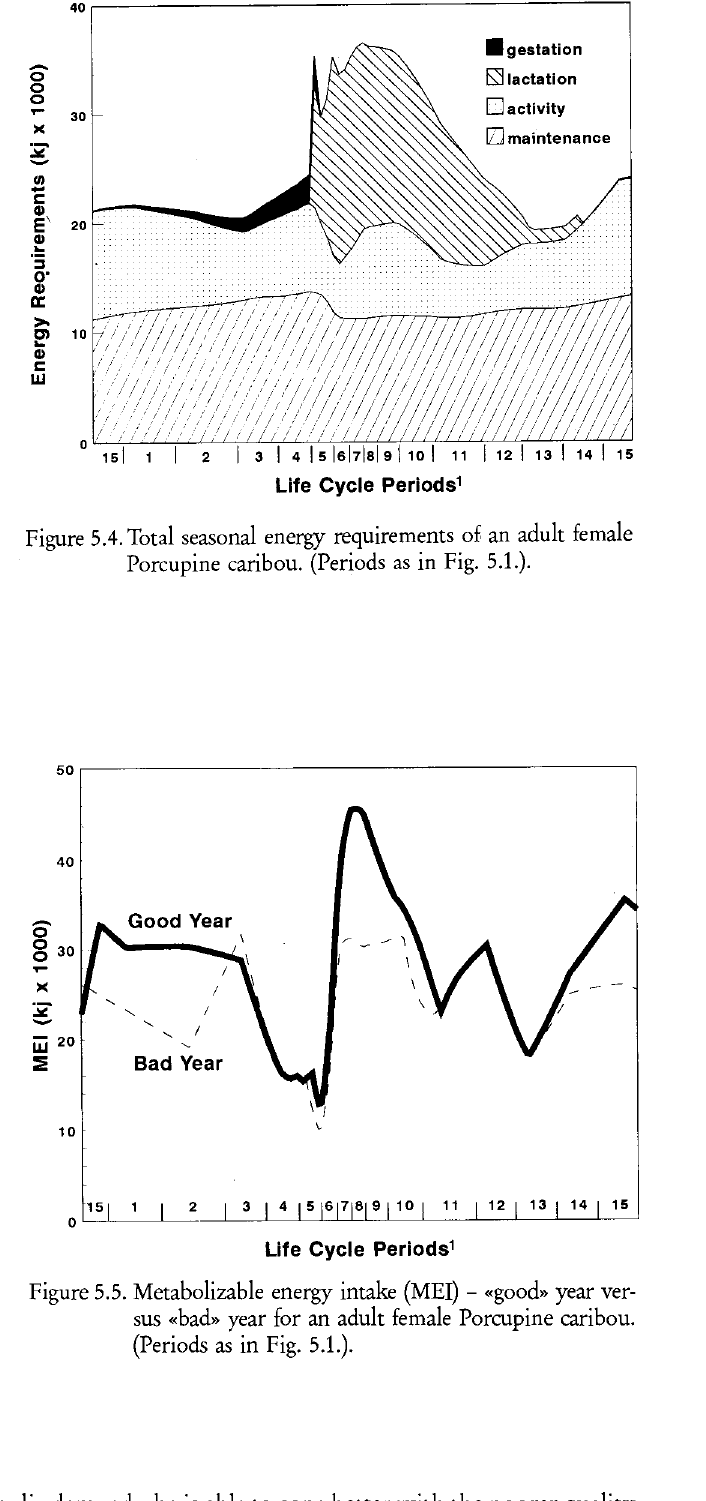
Figure 5.5. Metabolizable energy intake (MEI) - «good» year ver sus «bad» year for an adult female Porcupine caribou. (Periods as in Fig.